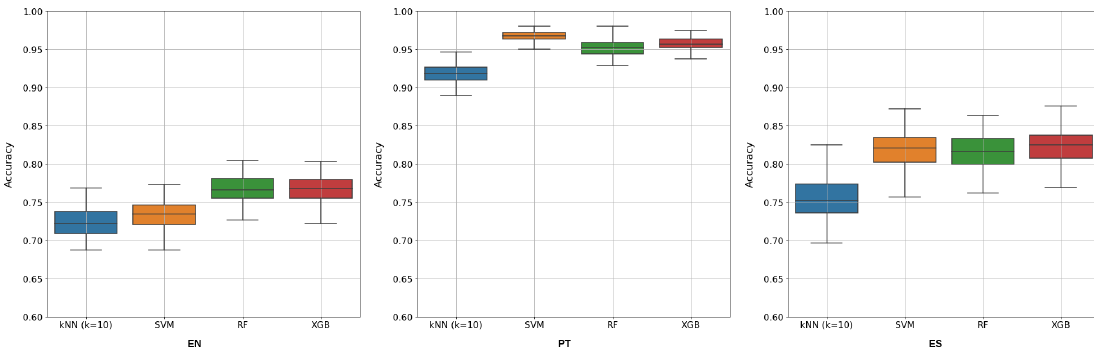
Figure 3. Results of cross-validation for each algorithm ( k -Nearest Neighbors ( k -NN), Support Vector Machine (SVM), Random Forest (RF), and Extreme Gradient Boosting (XGB)) showing accuracy distribution for all three datasets (English, Portuguese, and